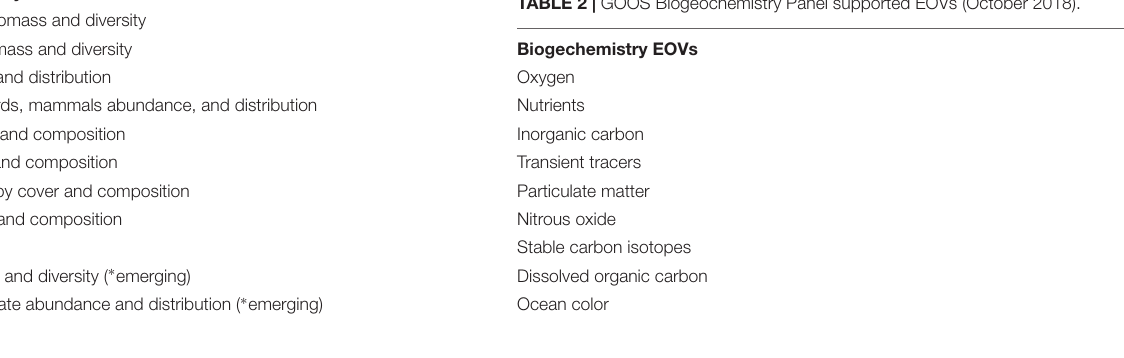
TABLE 2 | GOOS Biogeochemistry Panel supported EOVs (October